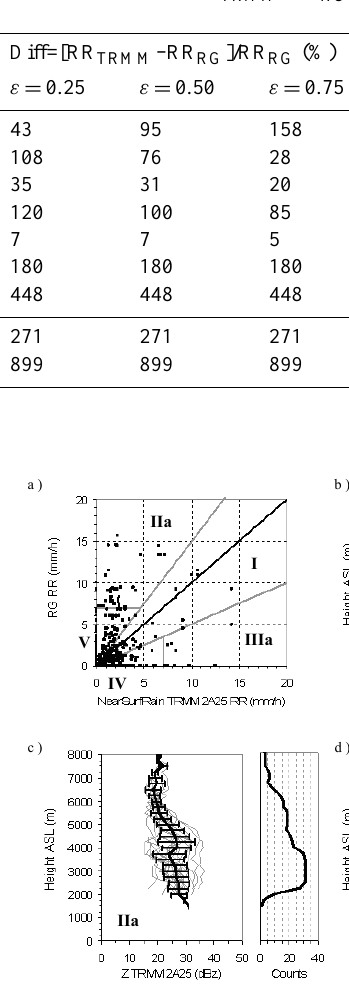
Table 3. Classification of TRMM 2A25 reflectivity profiles as a function of the difference [RR TRMM –RR RG ]/RR RG (%).